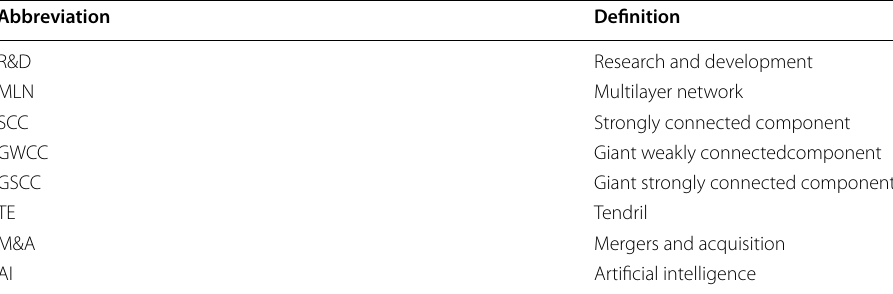
Table 1 List of